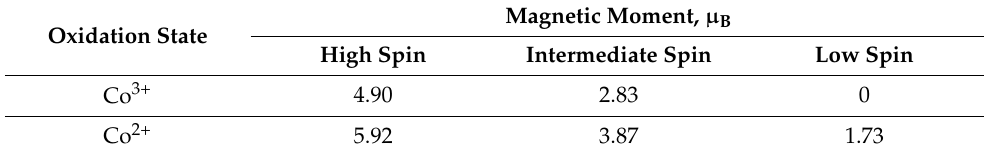
Table 6. Co 3+ /Co 2+ magnetic moments.